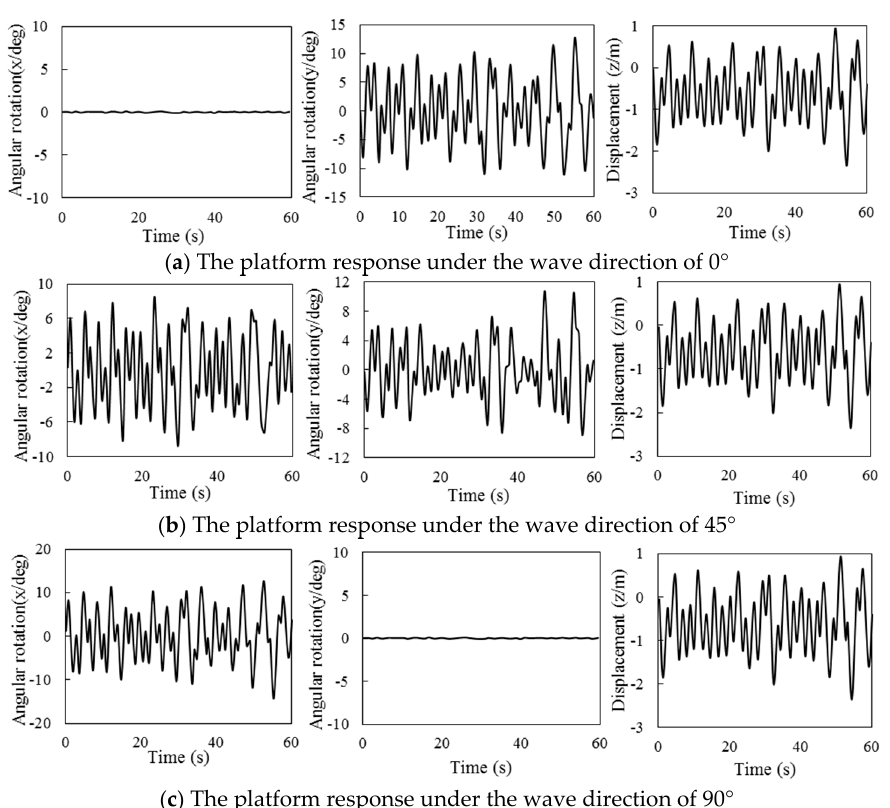
Figure 12. The platform response under wind − sea scale 4 with different wave directions.